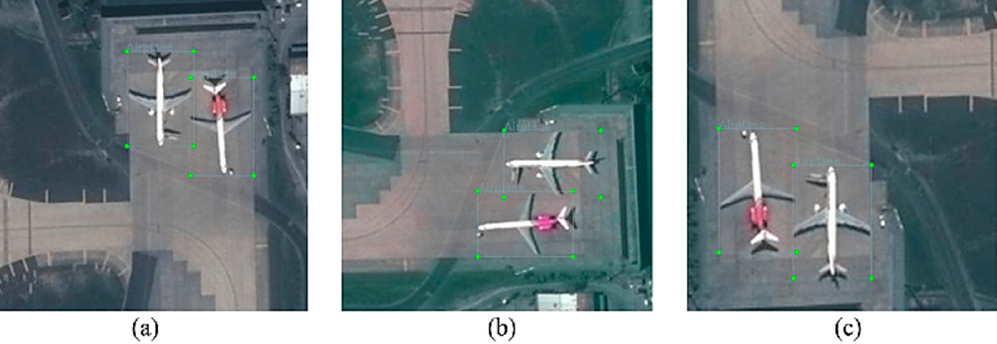
Figure 3. Augmented data: ( a ) original image chip; ( b ) Rotated and randomly scaled in HSV; ( c ) Rotated, randomly cropped, and scaled in HSV.